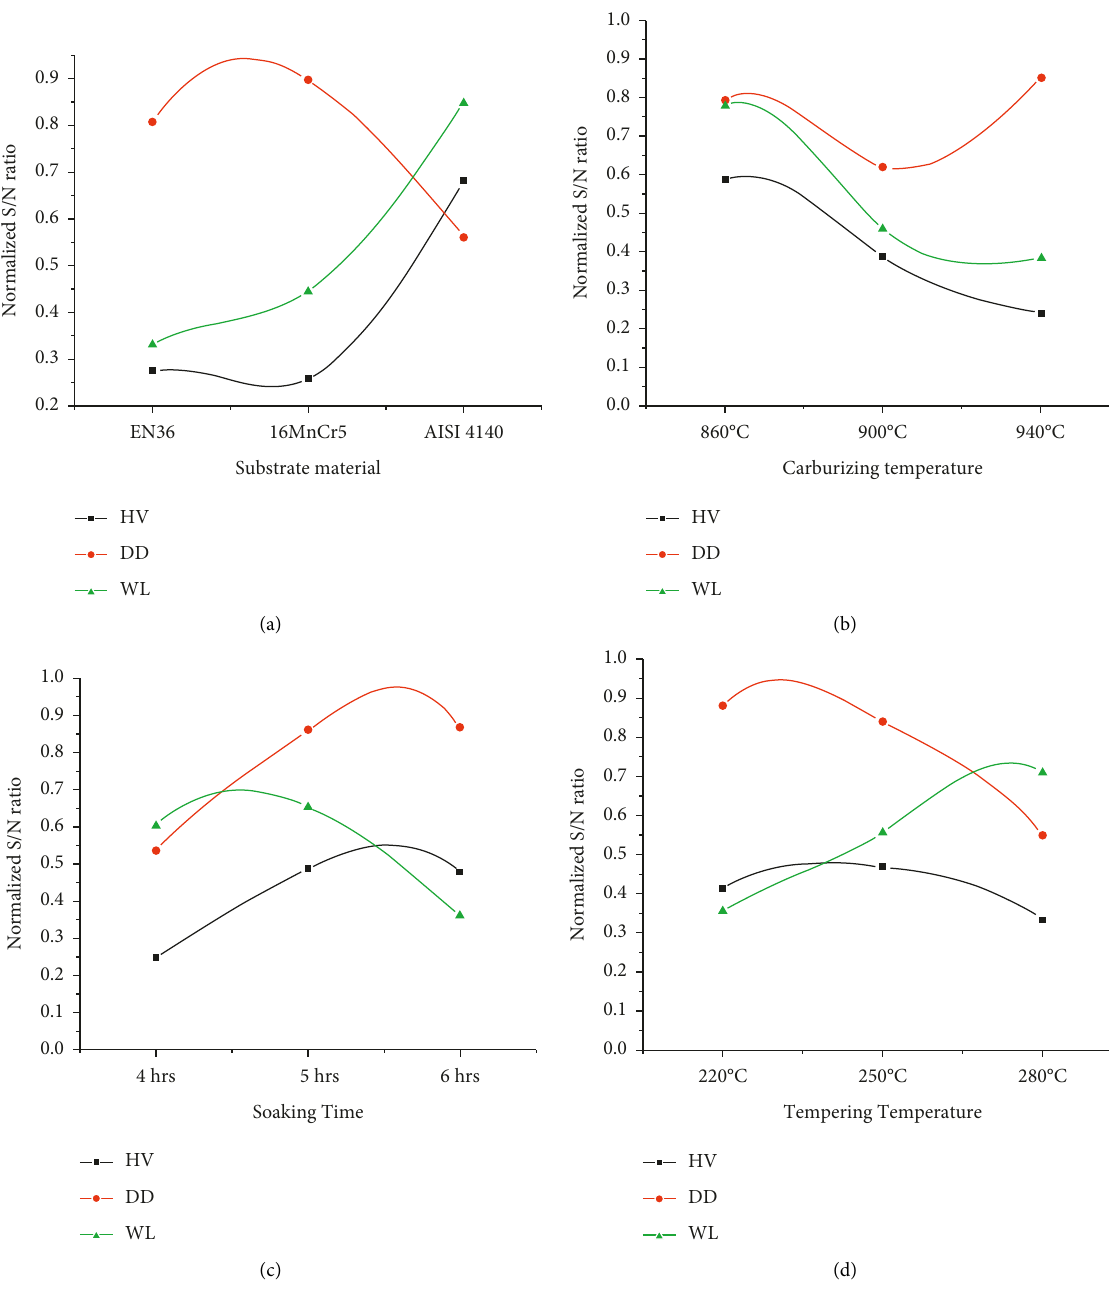
Figure 6: Parameter effects on quality characteristics. (a) Material substrate, (b) carburizing temperature, (c) soaking time, and (d) tempering temperature. Table 4: Pooled ANOVA on